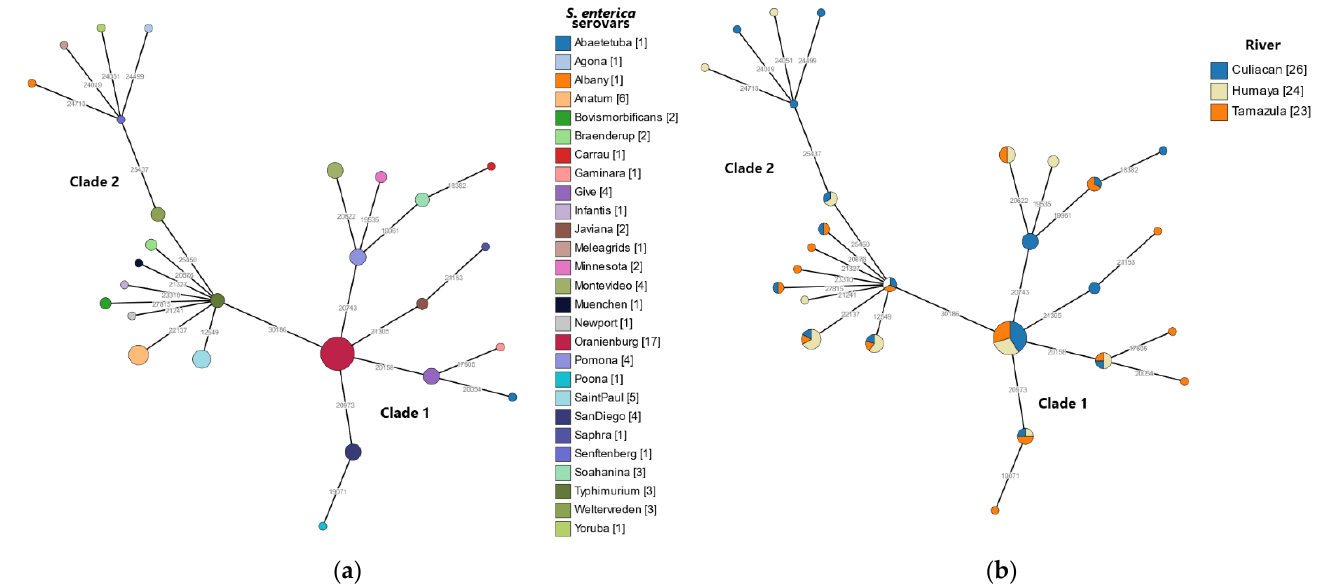
Figure 4. Minimum spanning tree of SNPs identified in the S. enterica isolates from river water samples in the Culiacan Valley, northwestern Mexico. An alignment of highly variable SNPs identified in the genomes of the recovered S. enterica isolates was generated using CSIPhylogeny version 1.4 [42]. The alignment was visualized using GrapeTree software with the MSTree V2 algorithim [44] to generate a minimum spanning tree. SNPs clusters were colored according to the detected serovar ( a ) or the sampled river ( b ) in the Culiacan Valley. Nodes less than 400 SNPs apart were collapsed to form a single SNP cluster, and the node size is indicative of the number of isolates.